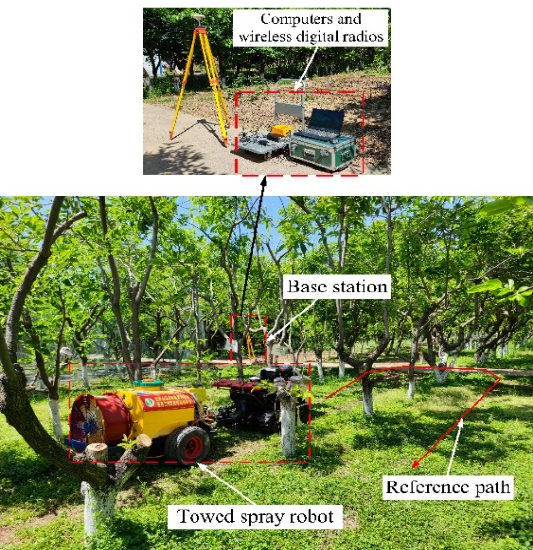
Figure 17. Navigation path-tracking real vehicle experiment.